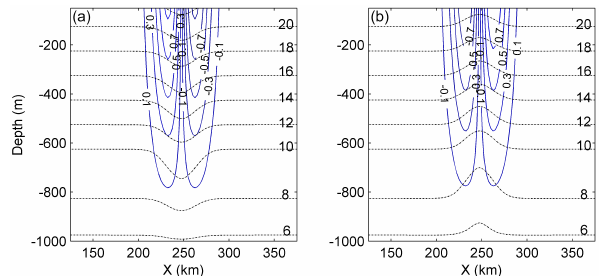
Figure 1. Initial velocity (ms − 1 ) and temperature ( ◦ C) profiles of the model warm eddy (a) and cold eddy (b)